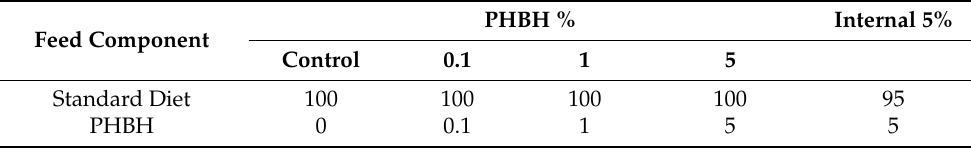
Table 2. Formulated compositions of the experimental